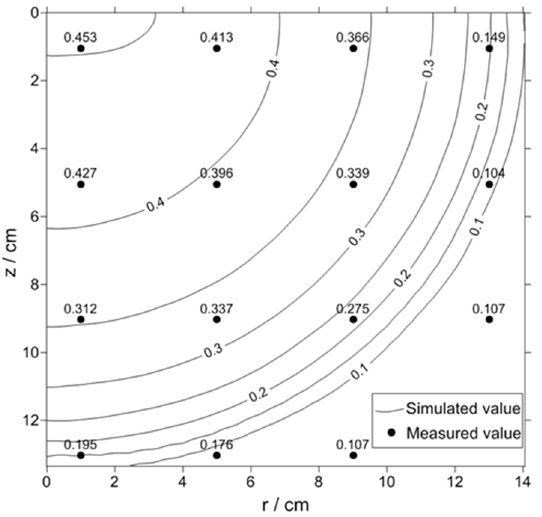
Figure 5. Contour map of soil water content of Xi’an silt loam after irrigation for 360 min.